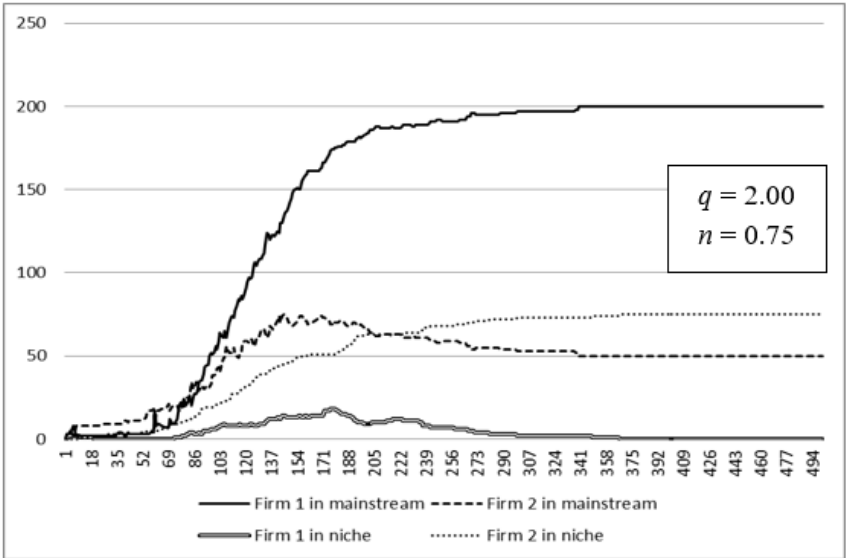
Figure 4. Competitive convergence, Firm 1 and Firm 2 both operate in the mainstream segment while Firm 2 operates in the niche segment (the network effect is weak and the preference in the mainstream segment is heterogeneous).